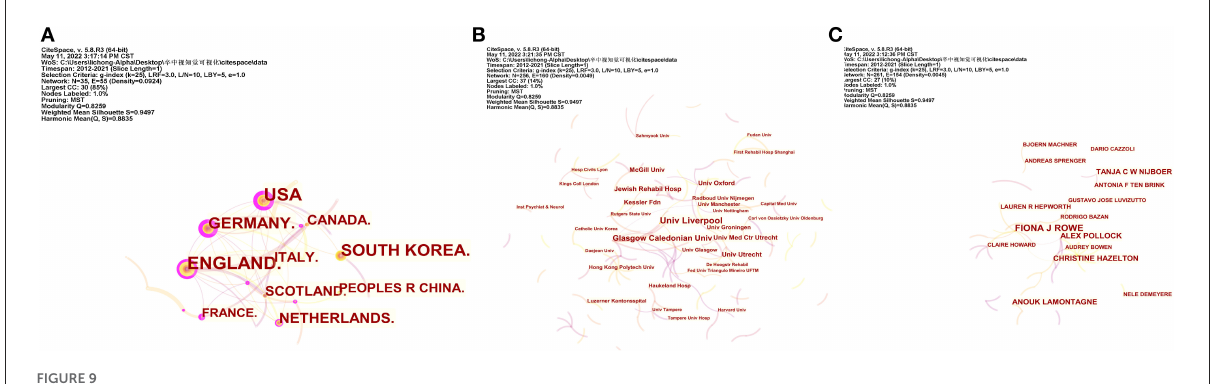
FIGURE9 The cooperative network analysis of countries, institutions, and authors. (A) Network map of countries. (B) Network map of institutions. (C) Network map of authors. A link indicates the presence of co-authorship or a co-occurrence